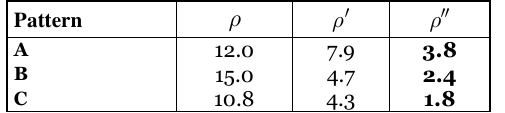
Table I. Summary of evaluation metrics CV of the measured and BRDF-corrected